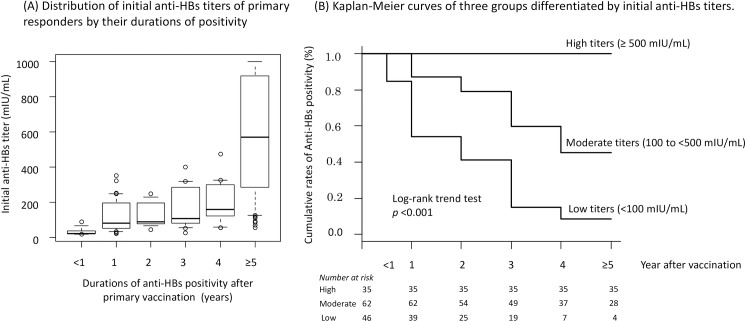
Initial anti-HBs titers of primary responders after full series of vaccination and its duration of positivity.(A) A box indicates a median and interquartile range, and error bars denote the 10th and 90th percentiles. (B) High (> 500 mIU/mL, n = 35), moderate (100–500 mIU/mL, n = 62), and low (< 100 mIU/mL, n = 46) titers. It was a significant trend that individuals with lower titers of initial anti-HBs experienced secondary vaccine response failure earlier.